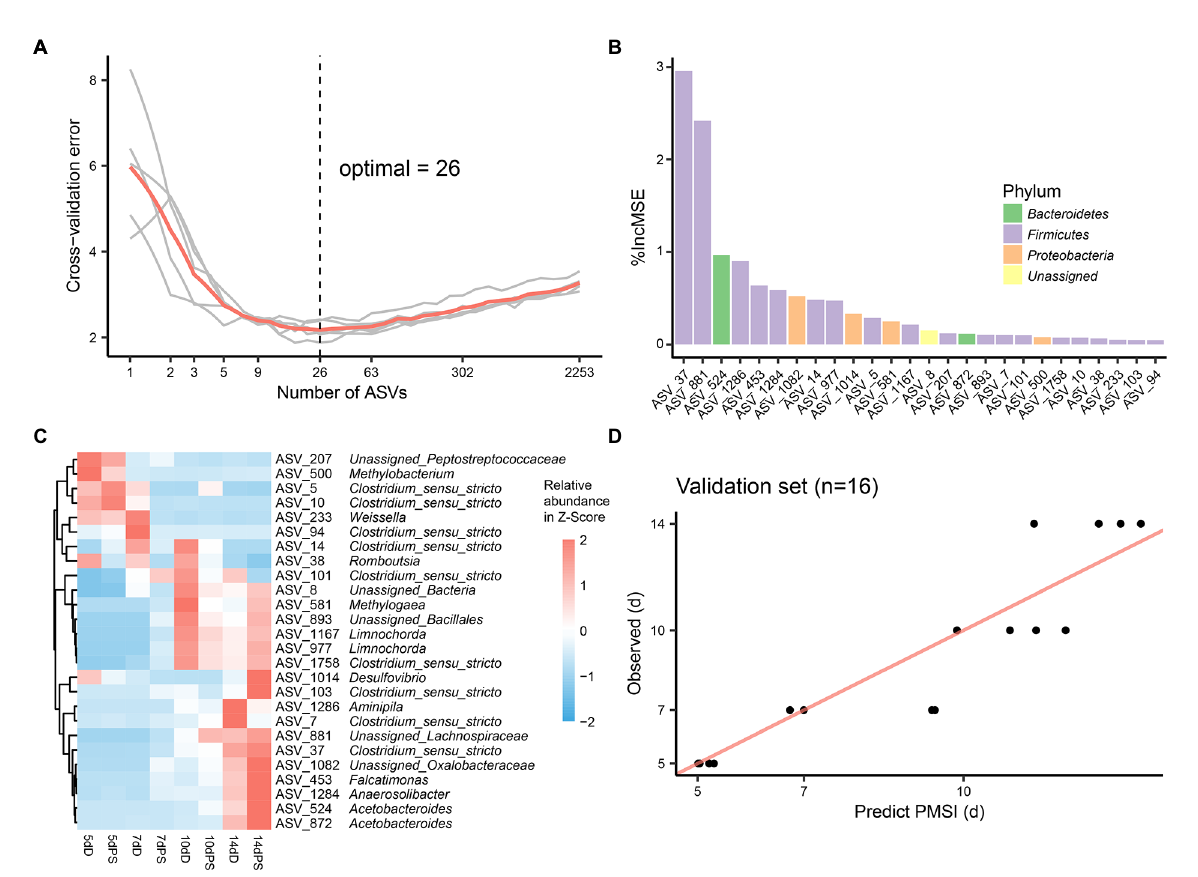
FIGURE 6 Brain biomarker identification and validation for PMSI estimation. (A) Cross-validation result of the initial model established using brain microbial communities. (B) The top 26 ASVs were identified by the RF algorithm. Biomarker taxa were ranked in decreasing order of importance (i.e., %IncMSE). (C) Heatmap demonstrating dynamic changes in abundance of the top 26 PMSI-predictive biomarkers. (D) Predicted PMSI versus actual PMSI for brain samples obtained by the refined regression model plotted with a superimposed one-to-one reference line. Dots represent brain samples from the validation experiment ( n = 4 per